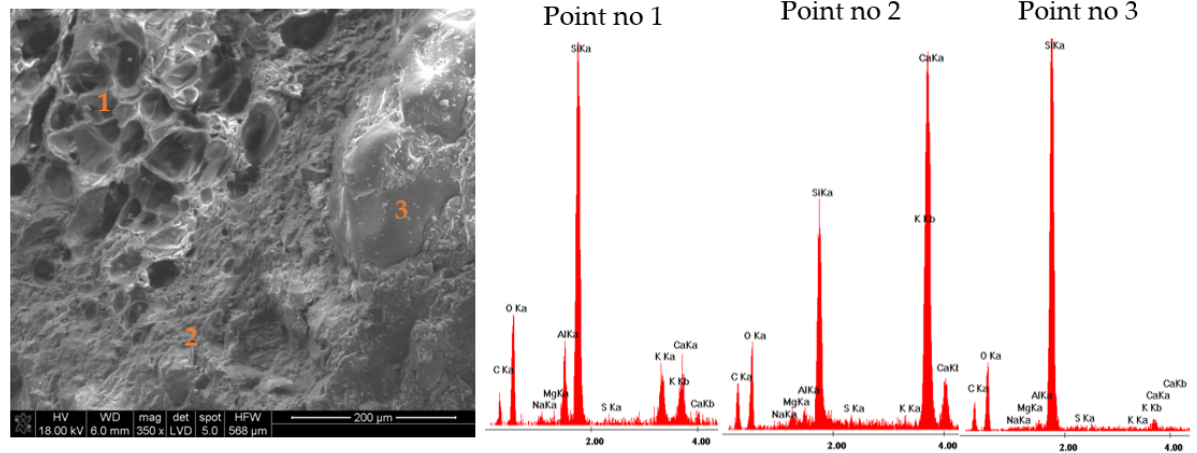
Figure 9. Microstructure of lightweight RPC with 30 vol.% of EP, cured for 28 days in 350 times magnification with EDS analysis in point 1, 2, and 3.